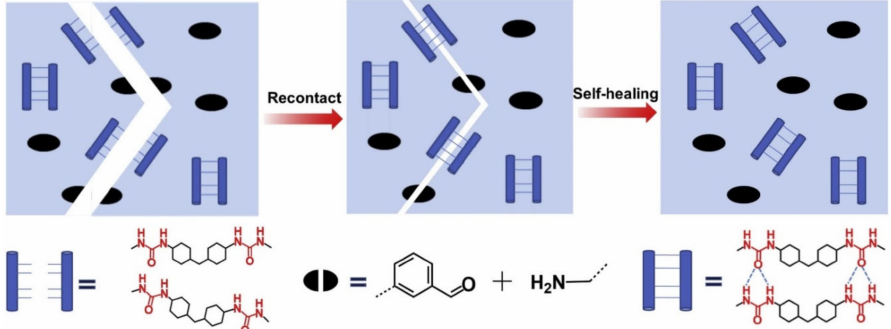
Figure 35. Schematic diagram of the self-healing mechanism. Reproduced from [188] with permission from